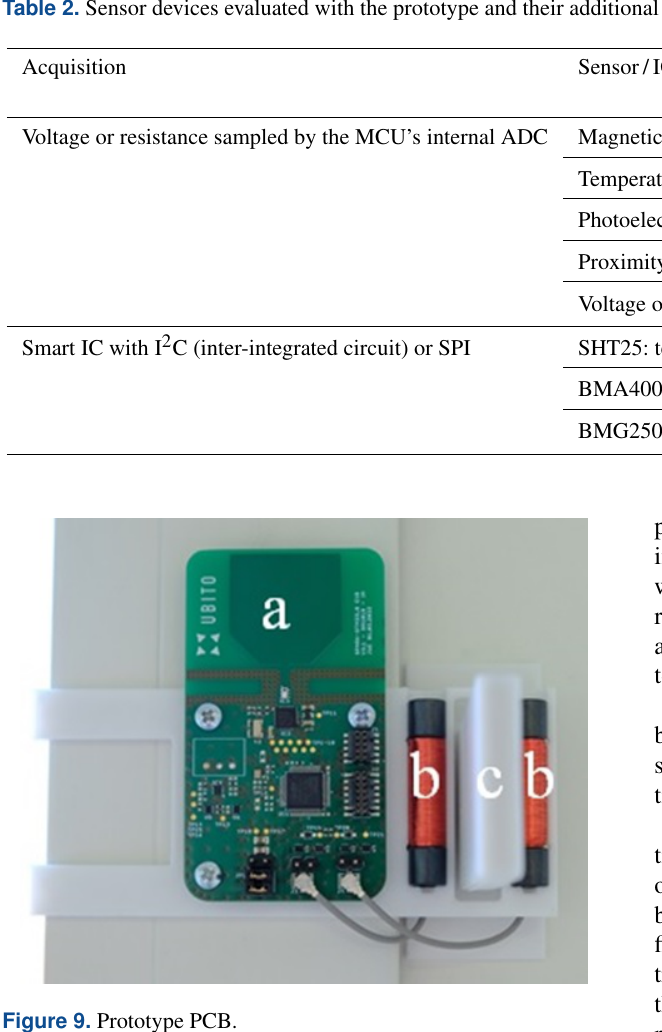
Table 2. Sensor devices evaluated with the prototype and their additional energy consumption.